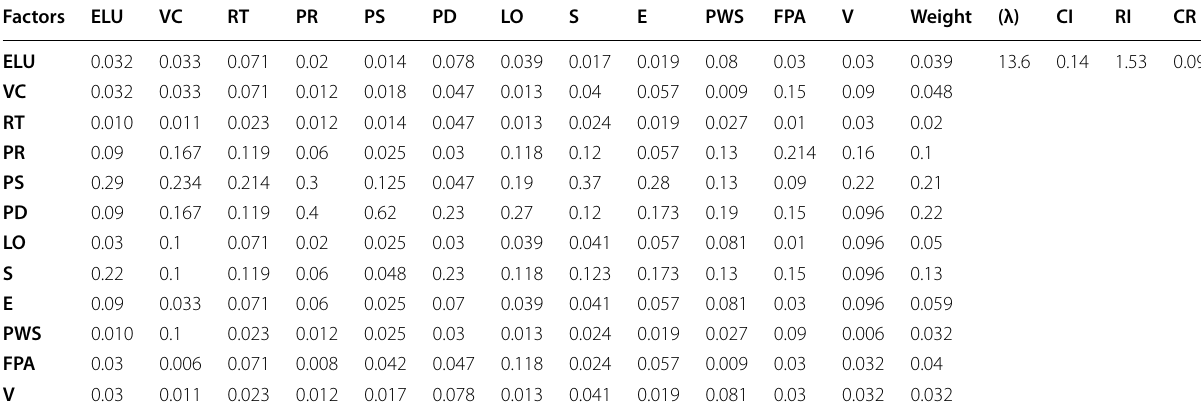
Table 5 Computation of the factor weight and estimates of consistency